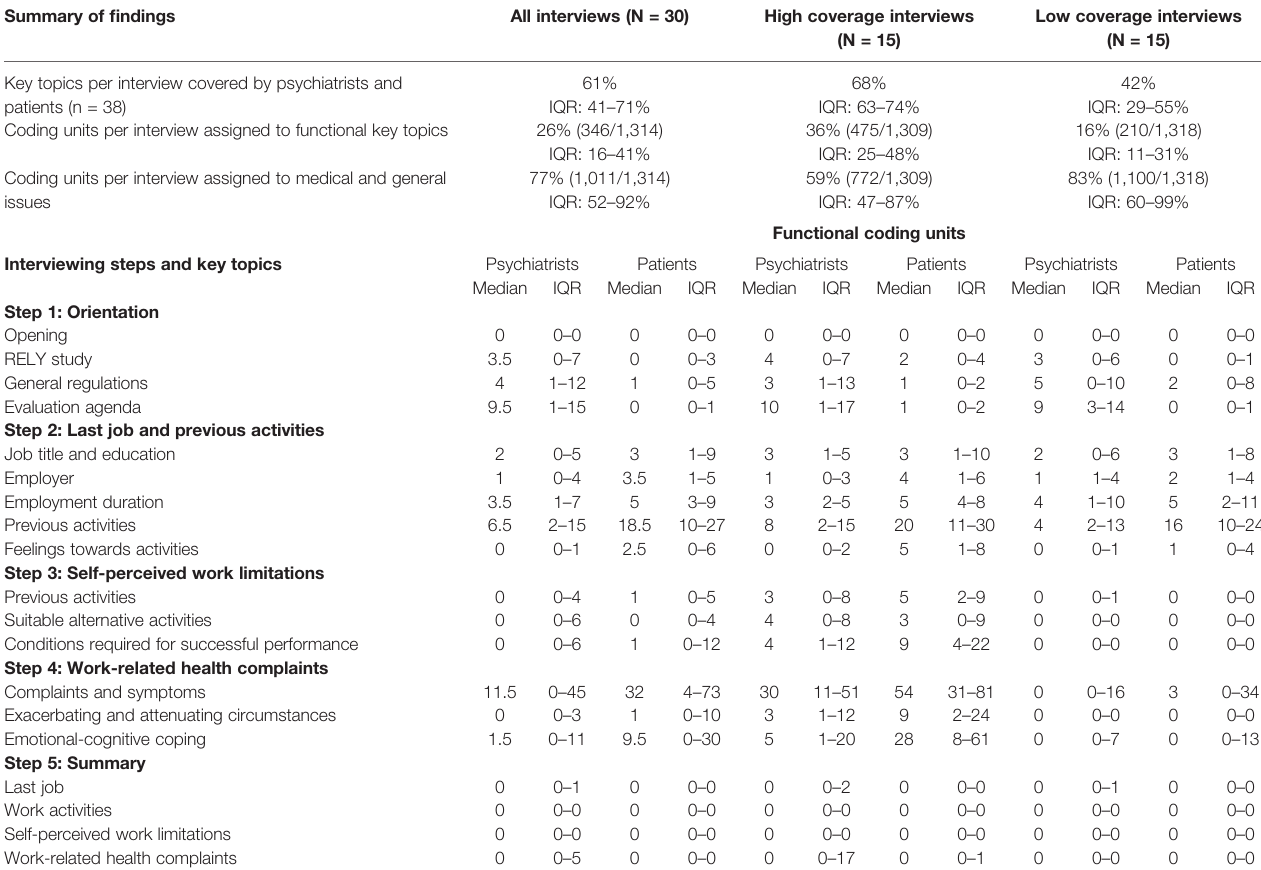
TABLE 2 | Time and effort spent on work-related functional key topics during the interview. Summary of fi